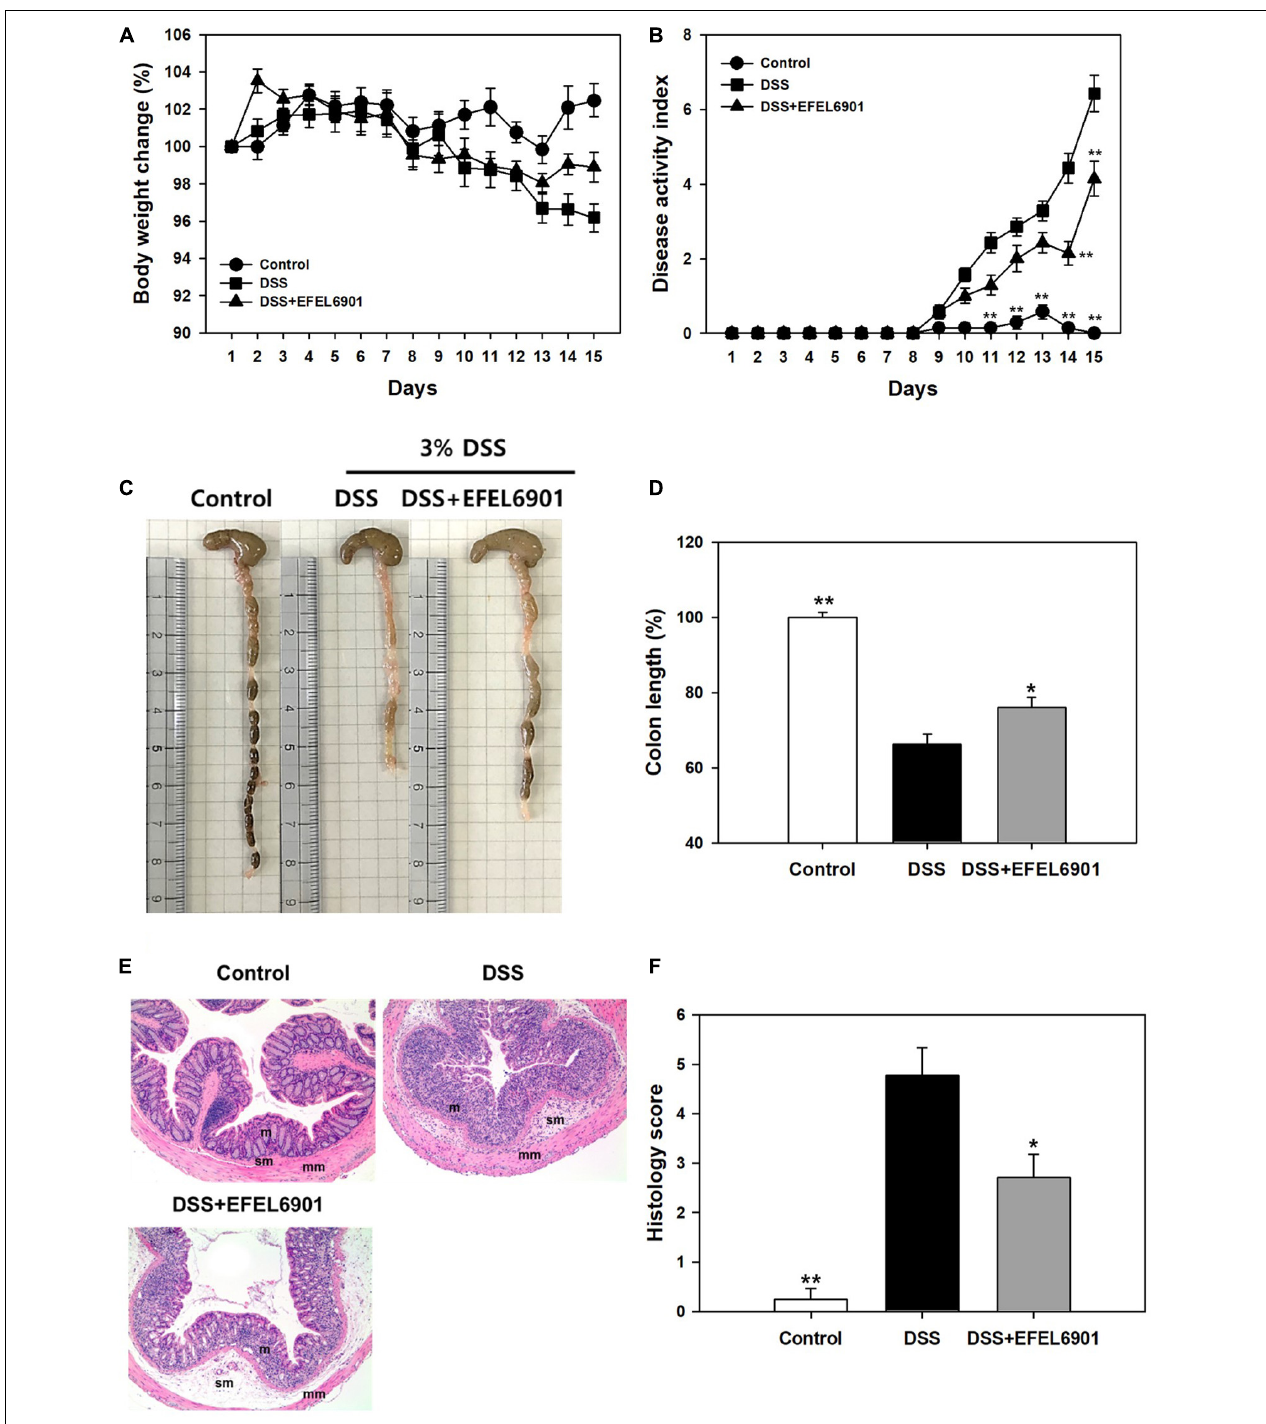
FIGURE 4 | Effects of Limosilactobacillus reuteri EFEL6901 strain on improvement of symptoms in DSS-induced murine colitis model. The body weight (A) and the disease activity index score (B) were evaluated throughout the experiment. After 15 days, the mice were sacrificed and colon lengths (C,D) were measured. (E) Histological features of a representative colon of each group. m, mucosa; sm, submucosa; mm, muscular layer. Mag. = X100 for all. (F) The histological score combining inflammatory cell infiltration and loss of intestinal glands. Results are expressed as means ± standard error ( n = 7). Significant differences are presented with the DSS group: * p < 0.05; ** p <